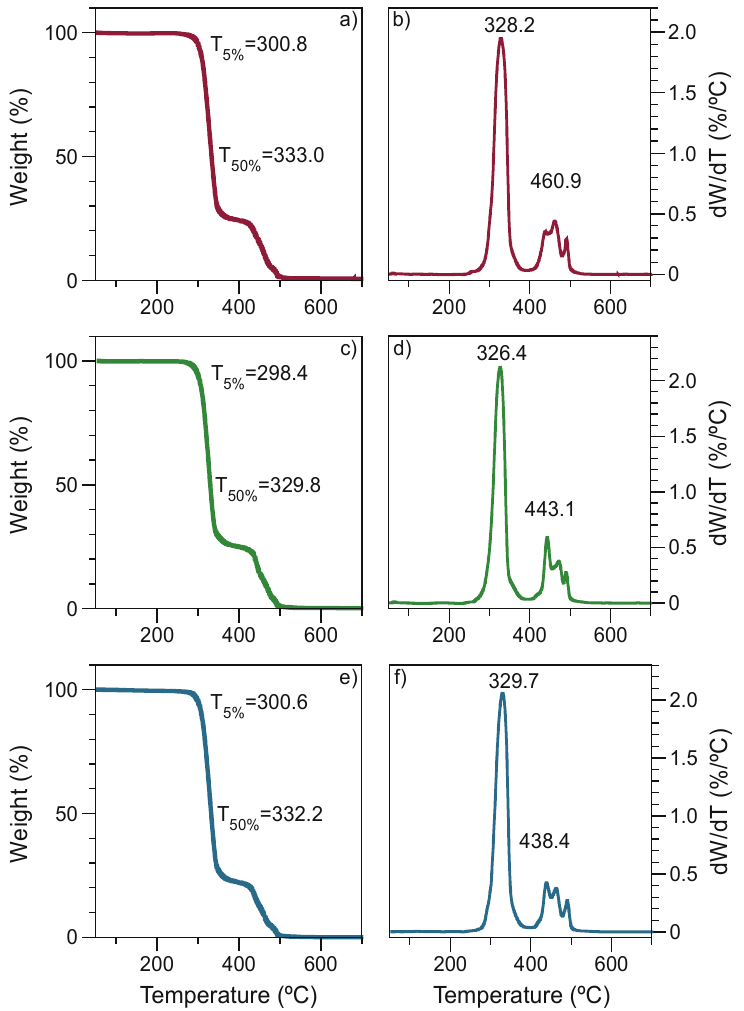
Figure 4. Thermograms of ternary blends. ( a ) TGA of EPS 1; ( b ) Derivative of weight loss/temperature (dW/dT) of EPS 1; ( c ) TGA of EPS 2; ( d ) dW/dT of EPS 2; ( e ) TGA of EPS 3; ( f ) dW/dT of EPS 3.